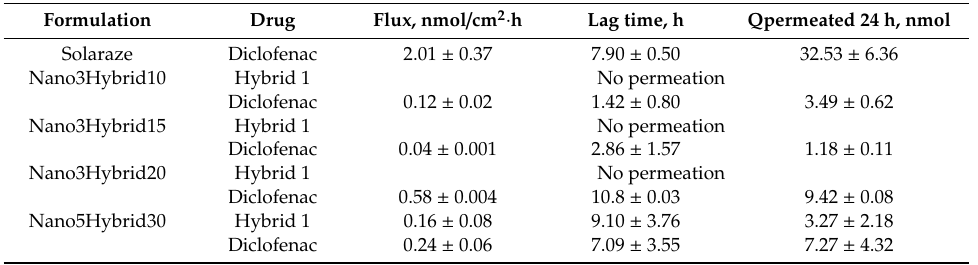
Table 3. Permeation parameters: flux (J), lag time and amount of drug permeated through the skin (Qpermeated24h) at end of the experiment (24 h) from the formulations under study (mean ± SEM, n =